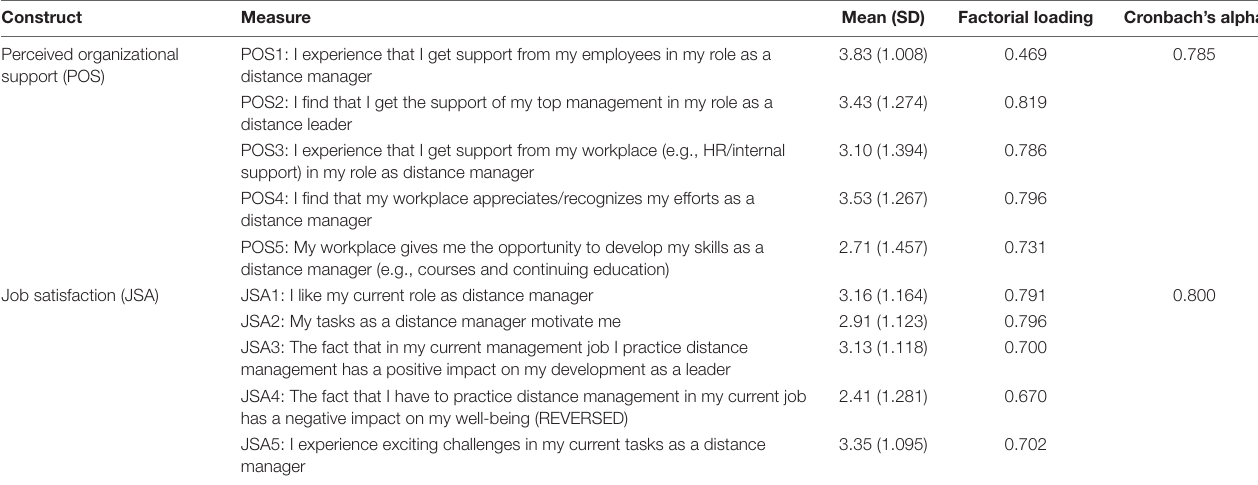
TABLE 2 | Scale information. Construct Measure Mean (SD) Perceived organizational support